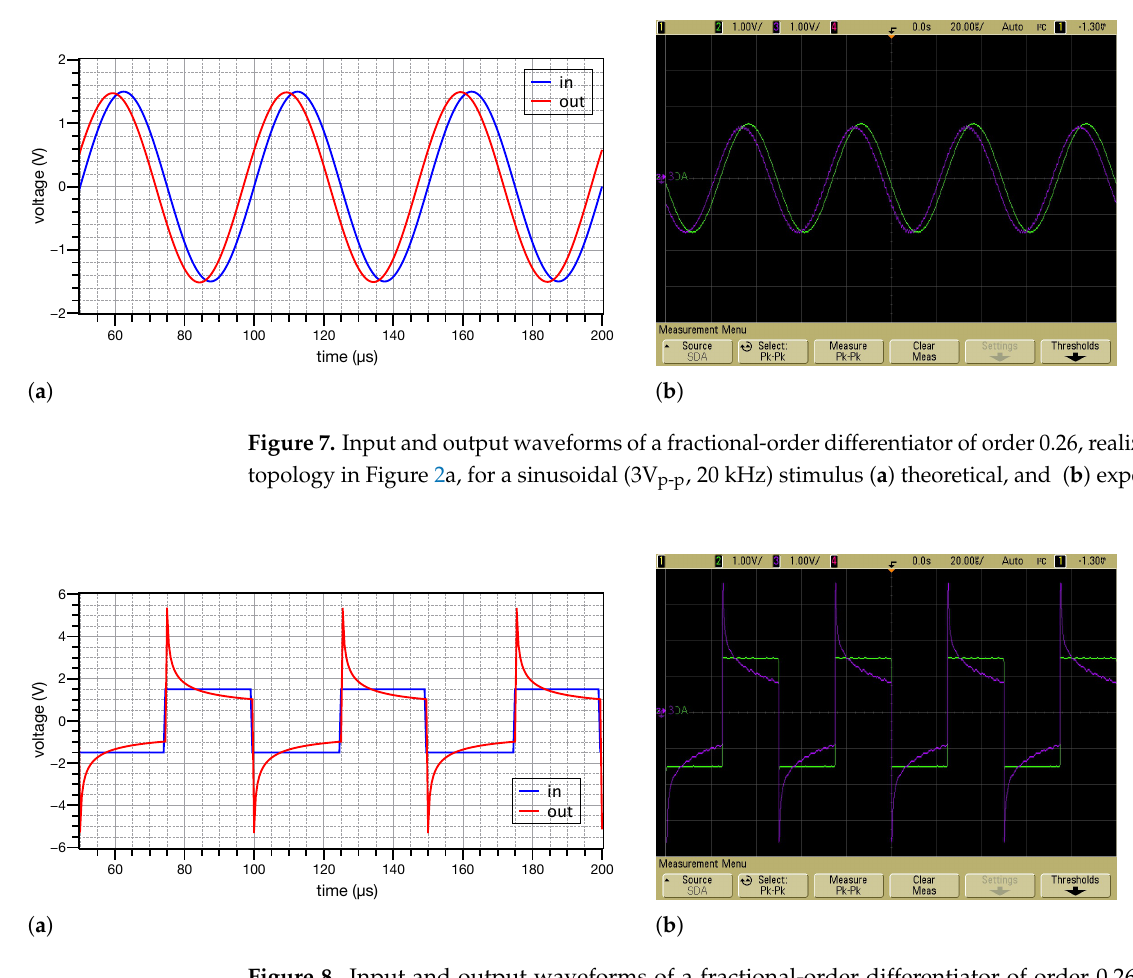
Figure 8. Input and output waveforms of a fractional-order differentiator of order 0.26, realized by the topology in Figure 2a, for a square wave (3 V p-p , 20 kHz) stimulus ( a ) theoretical and ( b ) experimental.